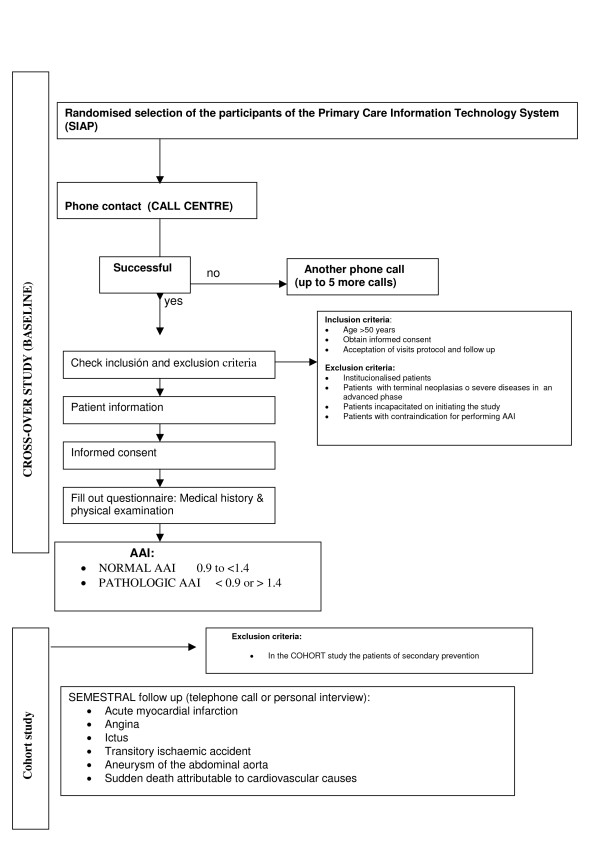
Flow diagram of the study.